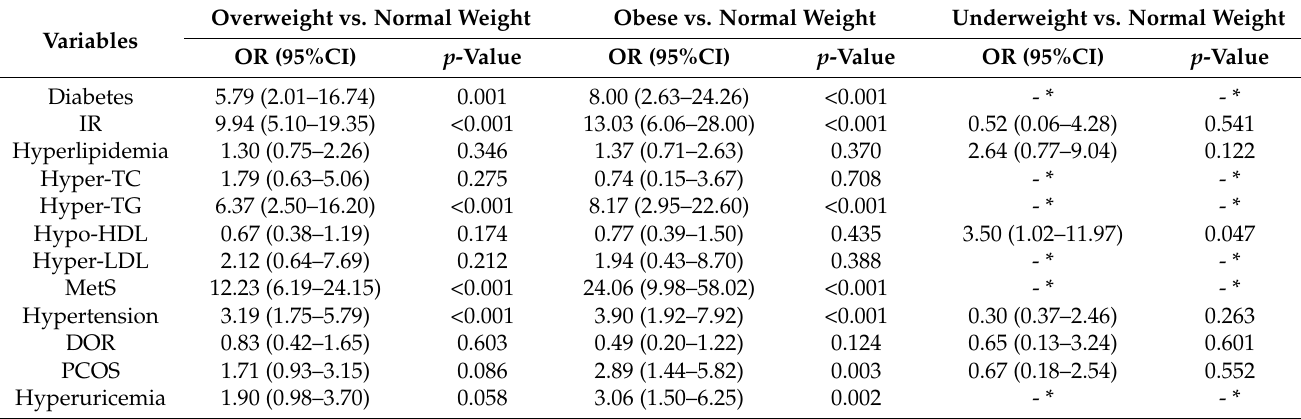
Table 2. Correlation between metabolic disorders and weight status.